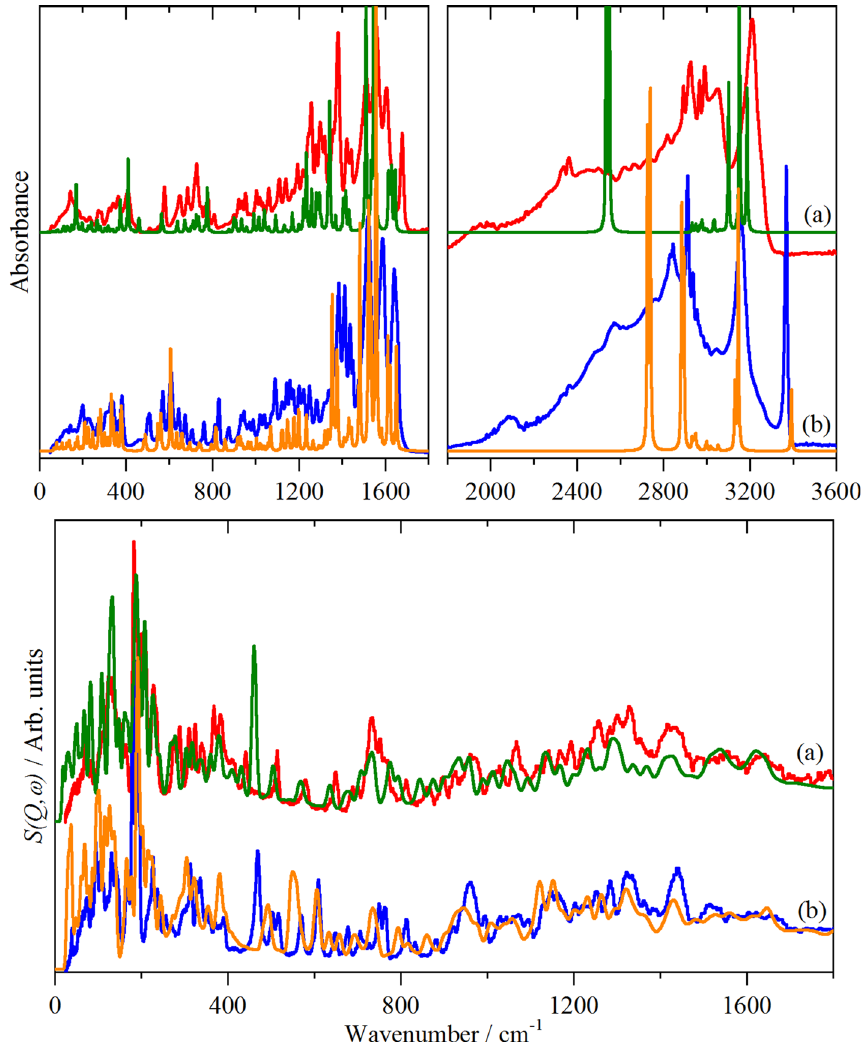
spectra are × 0.5 ordinate